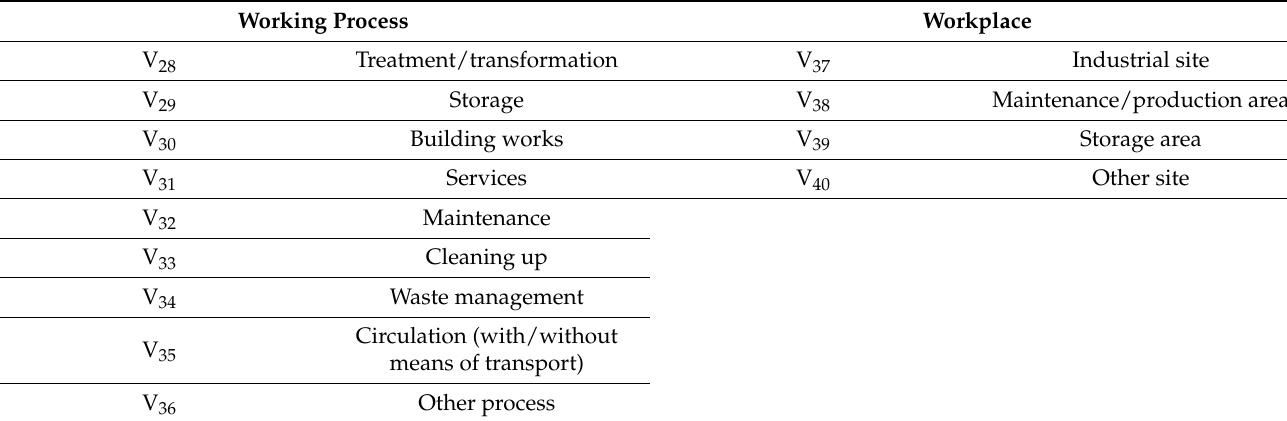
Table 8. Variables related to “Working Process” and “Workplace” factors.